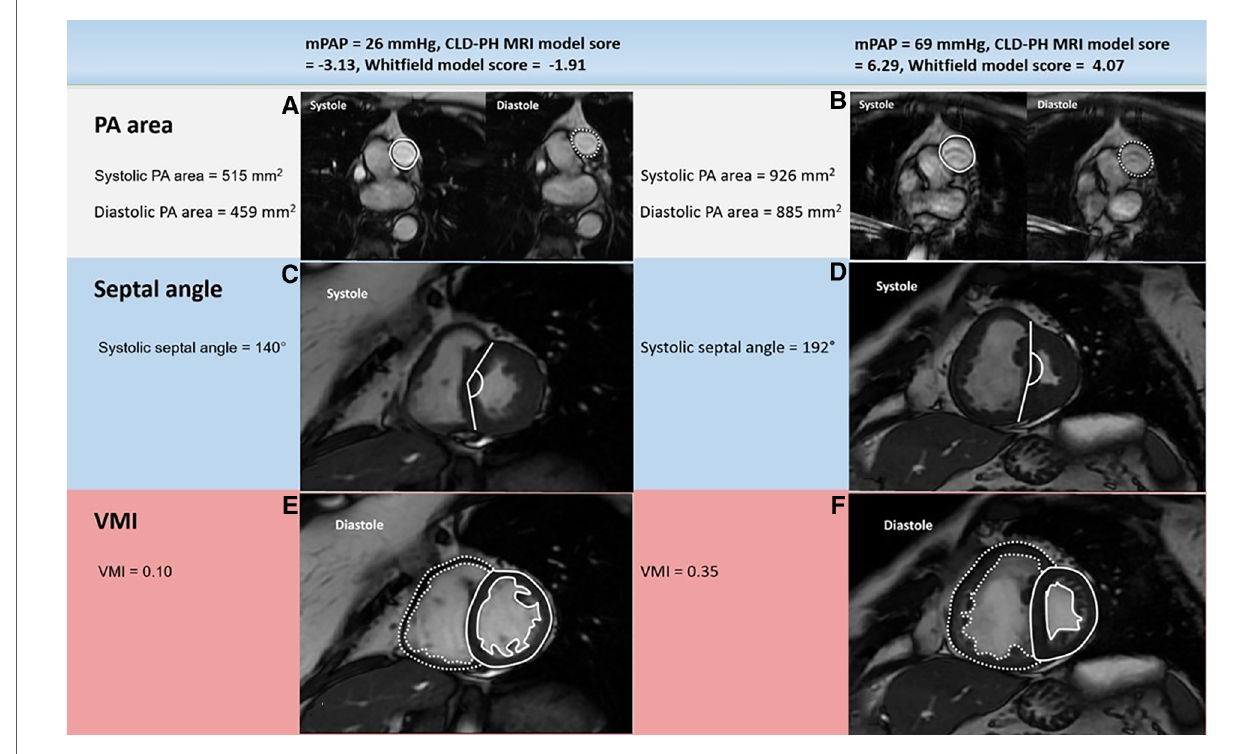
FIGURE 2 Example cardiac MRI images in patients with mPAP below (left) or above (right) 35 mmHg: PA area ( A, B ), systolic septal angle ( C, D ) and VMI ( E, F ). The patient with severe PH (right) had much larger systolic and diastolic PA areas, systolic septal curvature and VMI than the patient with mild-moderate PH (left). mPAP: mean pulmonary artery pressure; CLD: chronic lung disease; PH: pulmonary hypertension; PA: pulmonary artery; VMI: ventricular mass index; MRI: magnetic resonance